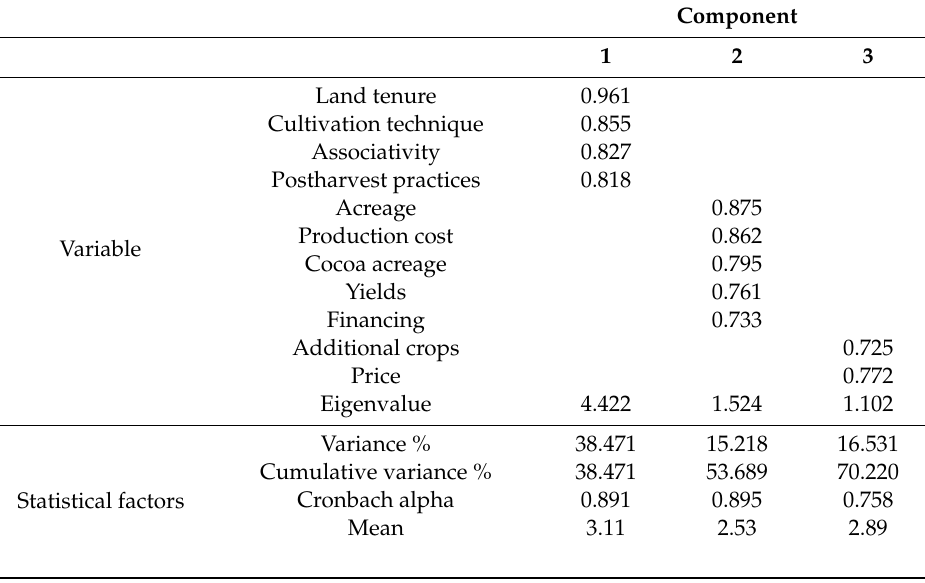
Table 6. Matrix of extracted components from PCA analysis of Arriba cocoa